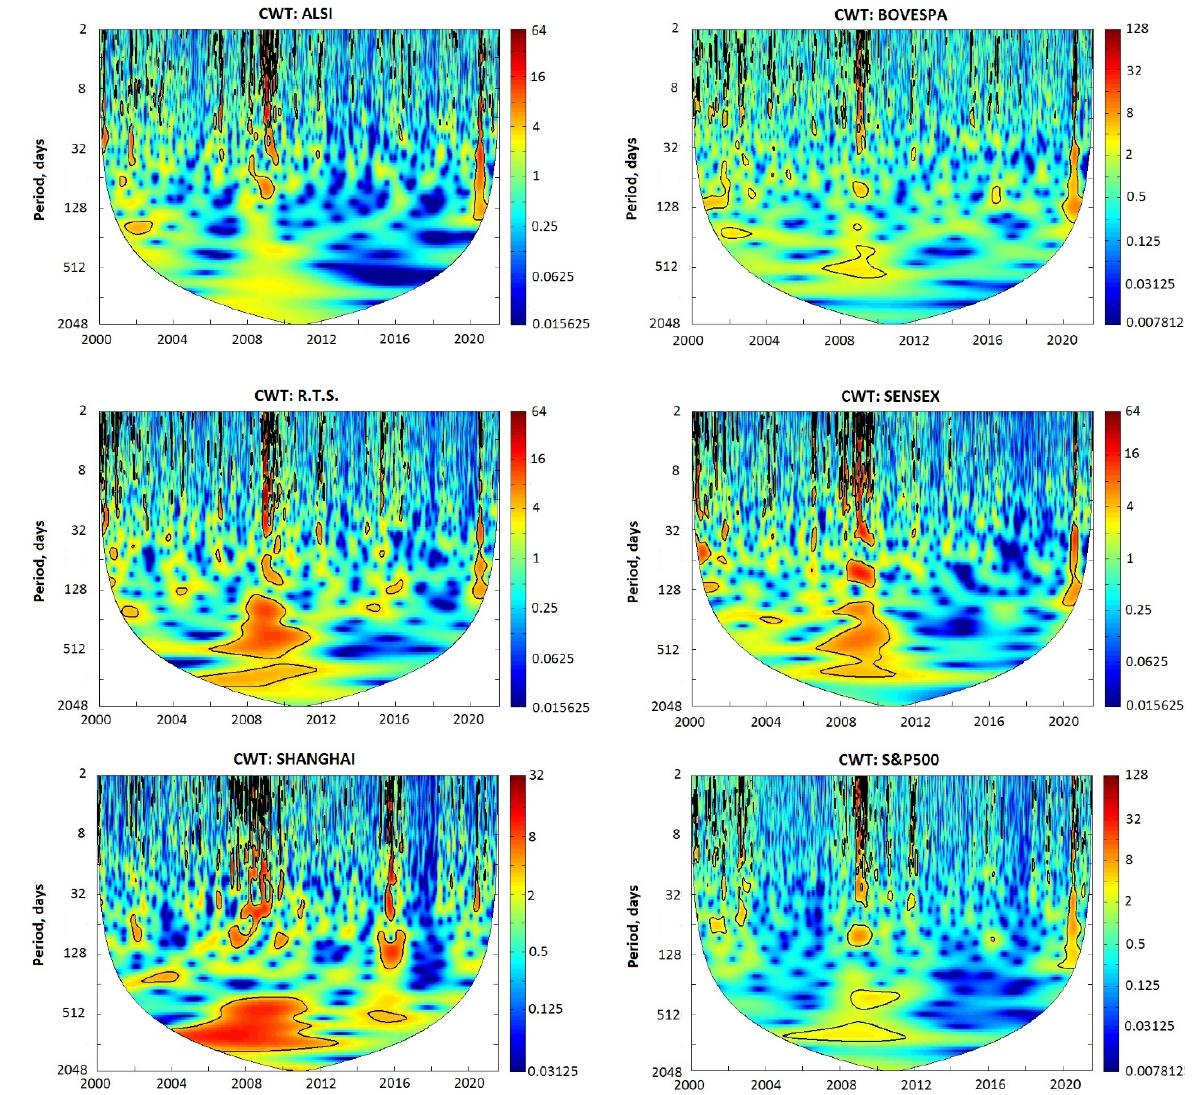
Figure 1. The continuous wavelet power spectrum of the BRICS and US stock market returns. The thick black contour indicates a 5% significance level against red noise. The cone of influence where edge effects might distort the picture is shown as a lighter shade. The power ranges from low (blue) to higher (red). The time in years and frequency in days are placed on the x- and y-axis, respectively. The horizontal axis represents the time component (years) and covers study